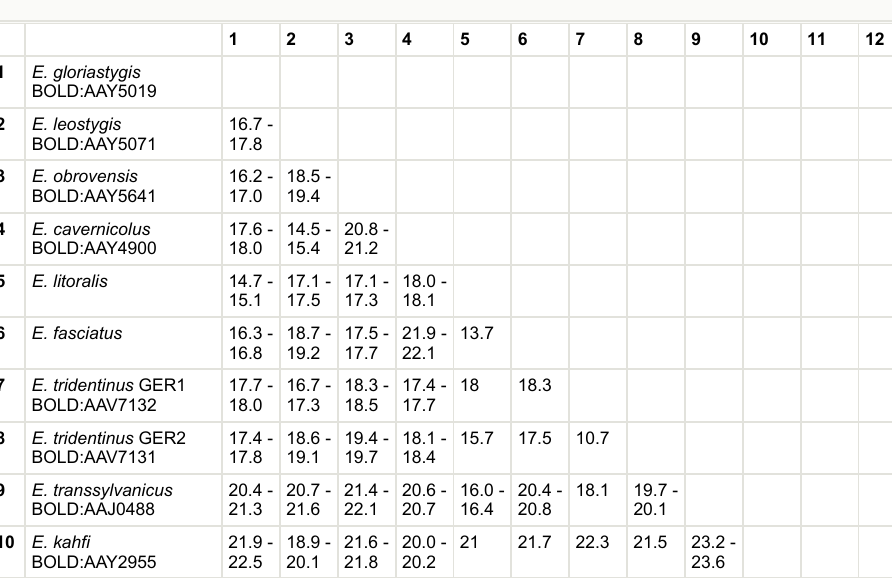
Interspecific genetic distances (K2P) of Eupolybothrus species. Given are the ranges from minimum to maximum